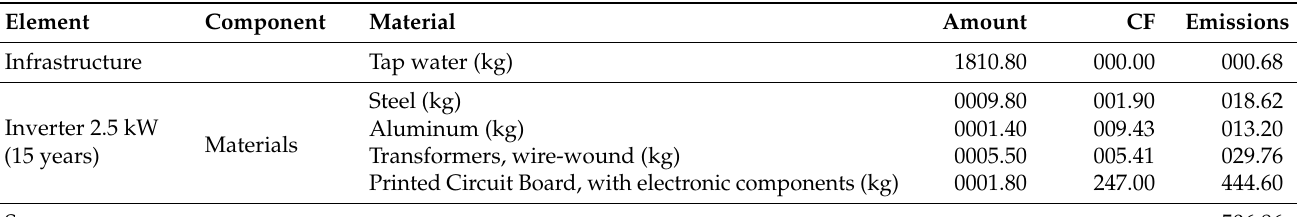
Table 9. Maintenance emissions from PV